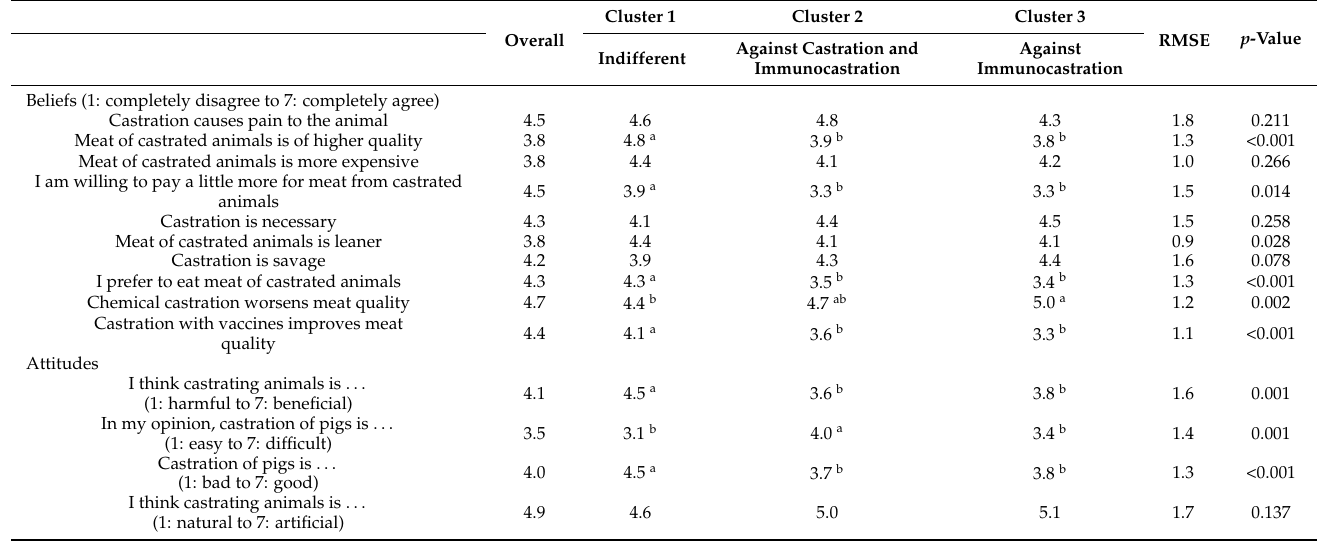
Cluster 1 Cluster Overall